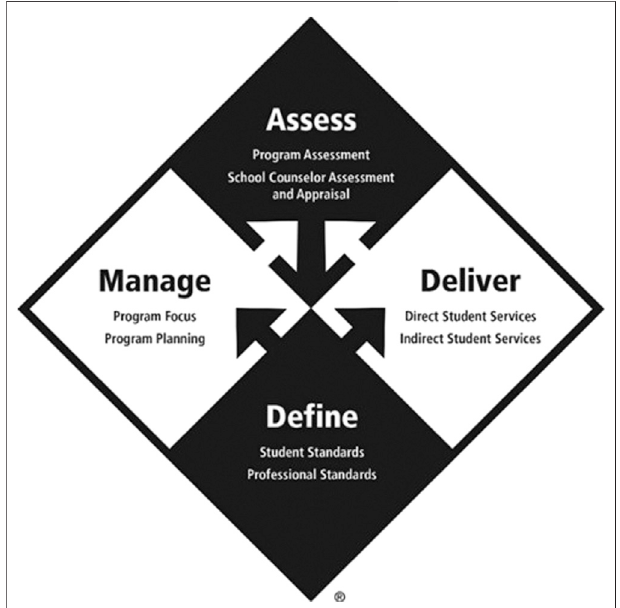
FIGURE 2 | The ASCA National Model Diagram (fourth edition). SOURCE: Reprinted with permission from the American School Counselor